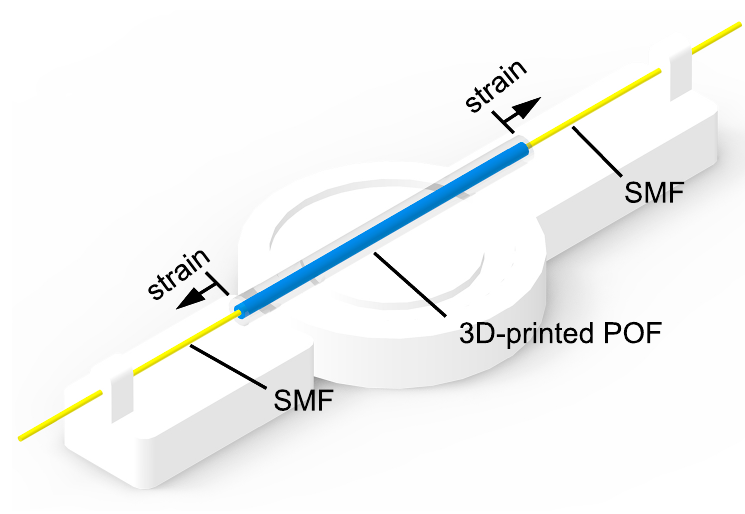
Figure 3. Interferometer strain measure